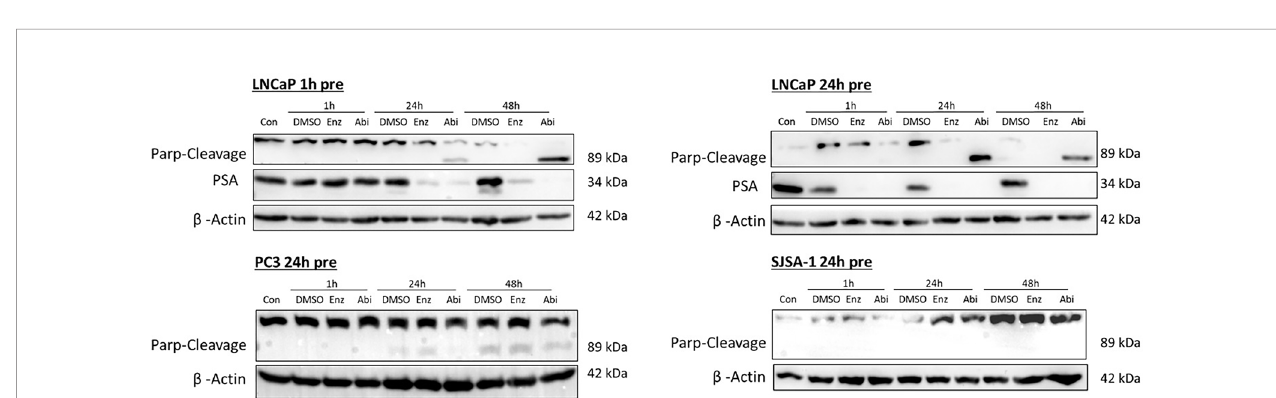
FIGURE 14 | Impact of Abiraterone and Enzalutamide and 2Gy radiation on PARP cleavage in AR-insensitive PC3s and AR-sensitive LNCaP prostate models and osteoblastic bone model SJSA-1. Models were treated with 10 m M Abiraterone, Enzalutamide or DMSO 1 or 24 hours before radiation with 2Gy. Samples were then harvested 1,24 and 48 hours post-radiation and expression levels measured via Western blot. b -Actin was used as a loading control.